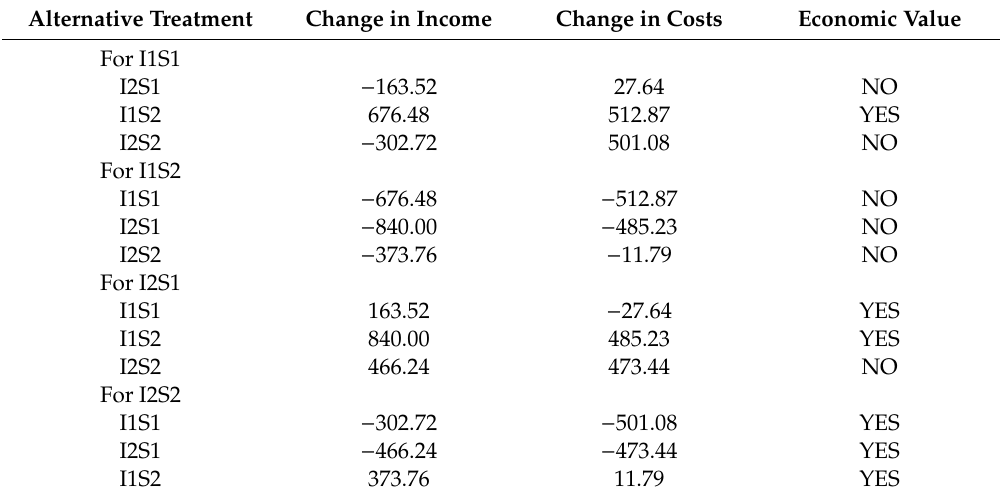
Table 8. Possibility of replacing I1S1, I1S2, I2S1, and I2S2 treatments regarding the economical aspect. Alternative Treatment Change in